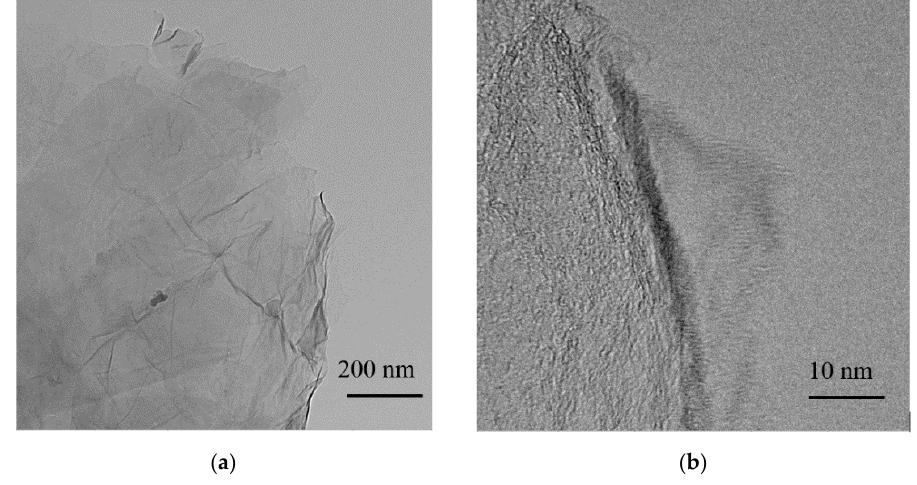
Figure 5. ( a ) Transmission electron microscopy (TEM) and ( b ) high-resolution (HR-TEM images of GO made by magnetically stirring.